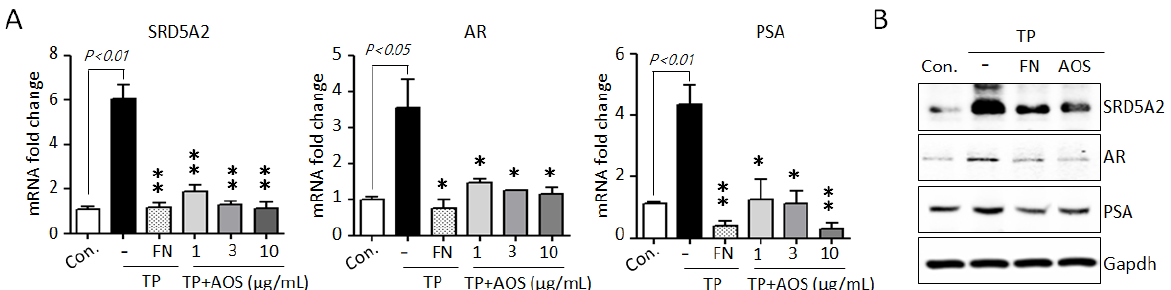
Figure 2. AOS inhibits the expression of 5 α -reductase type 2 (SRD5A2), androgen receptor (AR), and pros-tate-specific antigen (PSA) in BPH-1 cells. ( A ) Levels of expression of SRD5A2, AR, and PSA mRNA were determined by real-time qPCR. BPH-1 cells were cultured in the absence (control; Con.) or presence of testosterone propionate (TP) 10 nM for 24 h, with or without finasteride (FN, 50 μM) or different concentrations of AOS (1, 3, and 10 μg/mL). The expression of target mRNA was normalized against that of b-actin (Actb), used as an internal control. Transcript levels are shown as fold activity relative to the control value. Data are represented as mean of three independent experiments ± standard deviation; * p < 0.05, and ** p < 0.01, compared with the control group (Con.) ( B ) Results of Western blot analysis. BPH-1 cells were cultured in the absence (Control, Con.) or presence of TP 10 nM, with 50 μM finasteride (FN) or 10 μg/mL AOS for 24 h. Glyceraldehyde -3-phosphate dehydrogenase (Gapdh) was used as an internal control. Data are representative of three independent experiments.